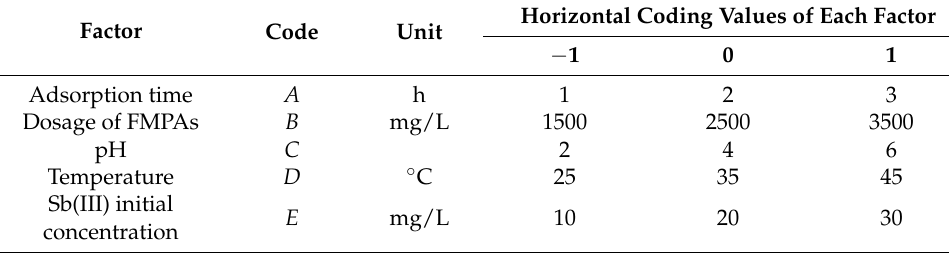
Table 1. Influencing factors and levels selected for the Box–Behnken experimental